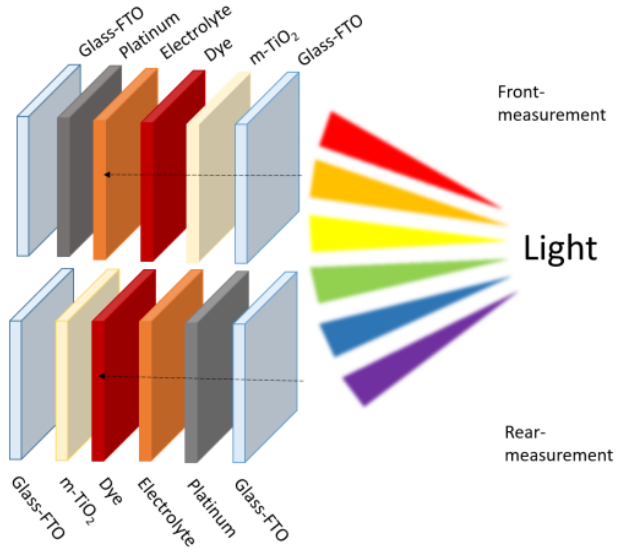
Figure 3. Graphic scheme of the front and rear lighting through the cell’s layers .